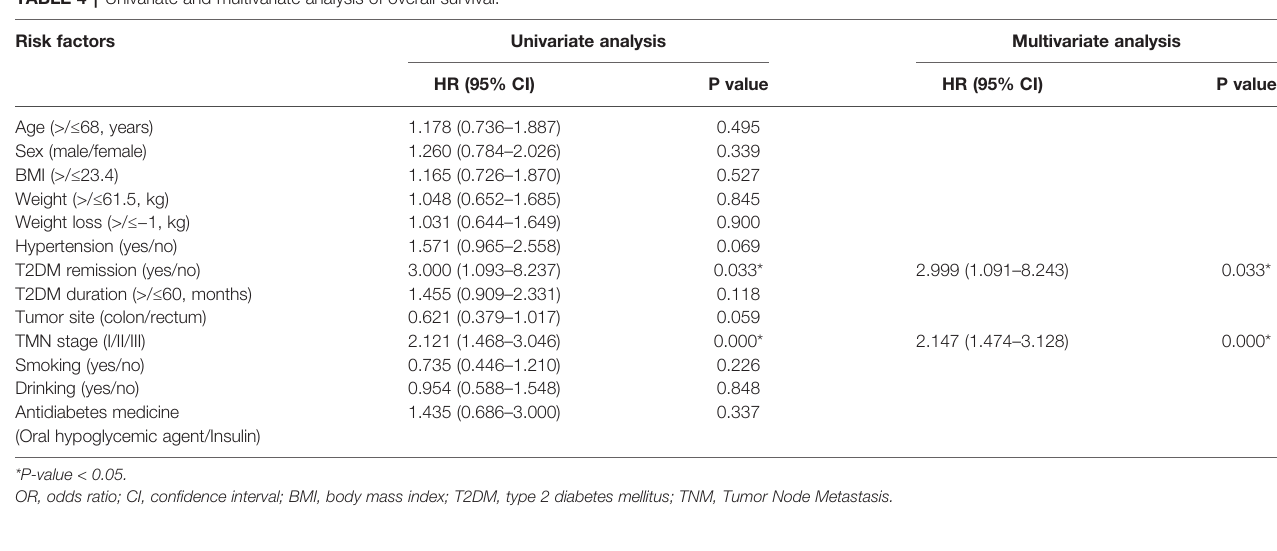
TABLE 4 | Univariate and multivariate analysis of overall survival.